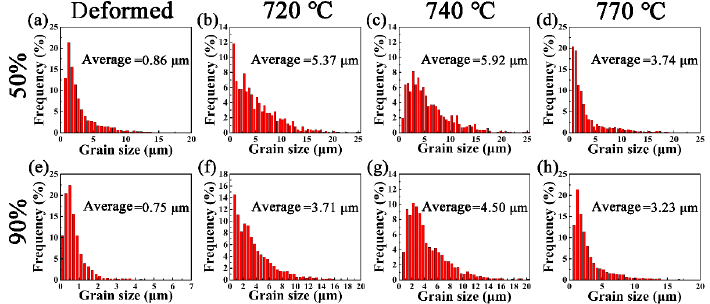
Figure 2. Grain size distribution of X2CrNi12 steel at 50% deformation ( a – d ) and 90% deformation ( e – h ) with different annealing temperatures, ( a , e ) deformed; ( b , f ) 720 °C; ( c , g ) 740 °C; ( d , h ) 770 °C.